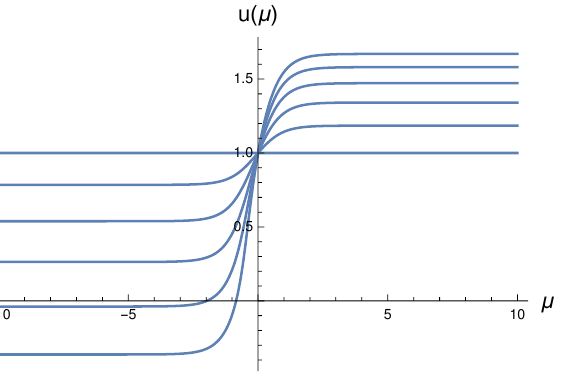
Figure 1 . Sample of solutions to (2.14) with u (0) = 1 and u 0 (0) 2 f 0 ; 0 : 2 ; 0 : 4 ; : : : ; 1 g . Their qualitative behavior is well captured by the leading-order perturbative solution